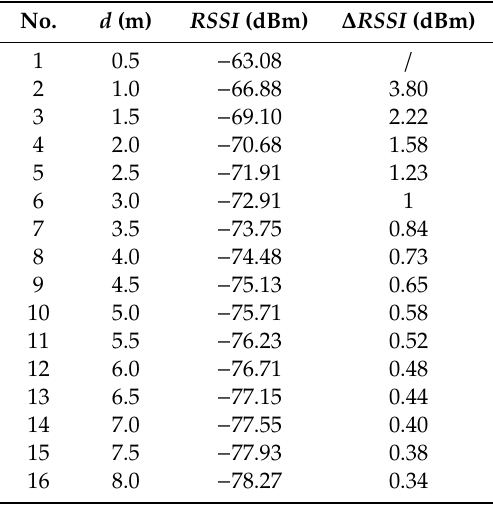
Table 1. Relationship between bluetooth low energy (BLE) received signal strength indication (RSSI) and physical distance.